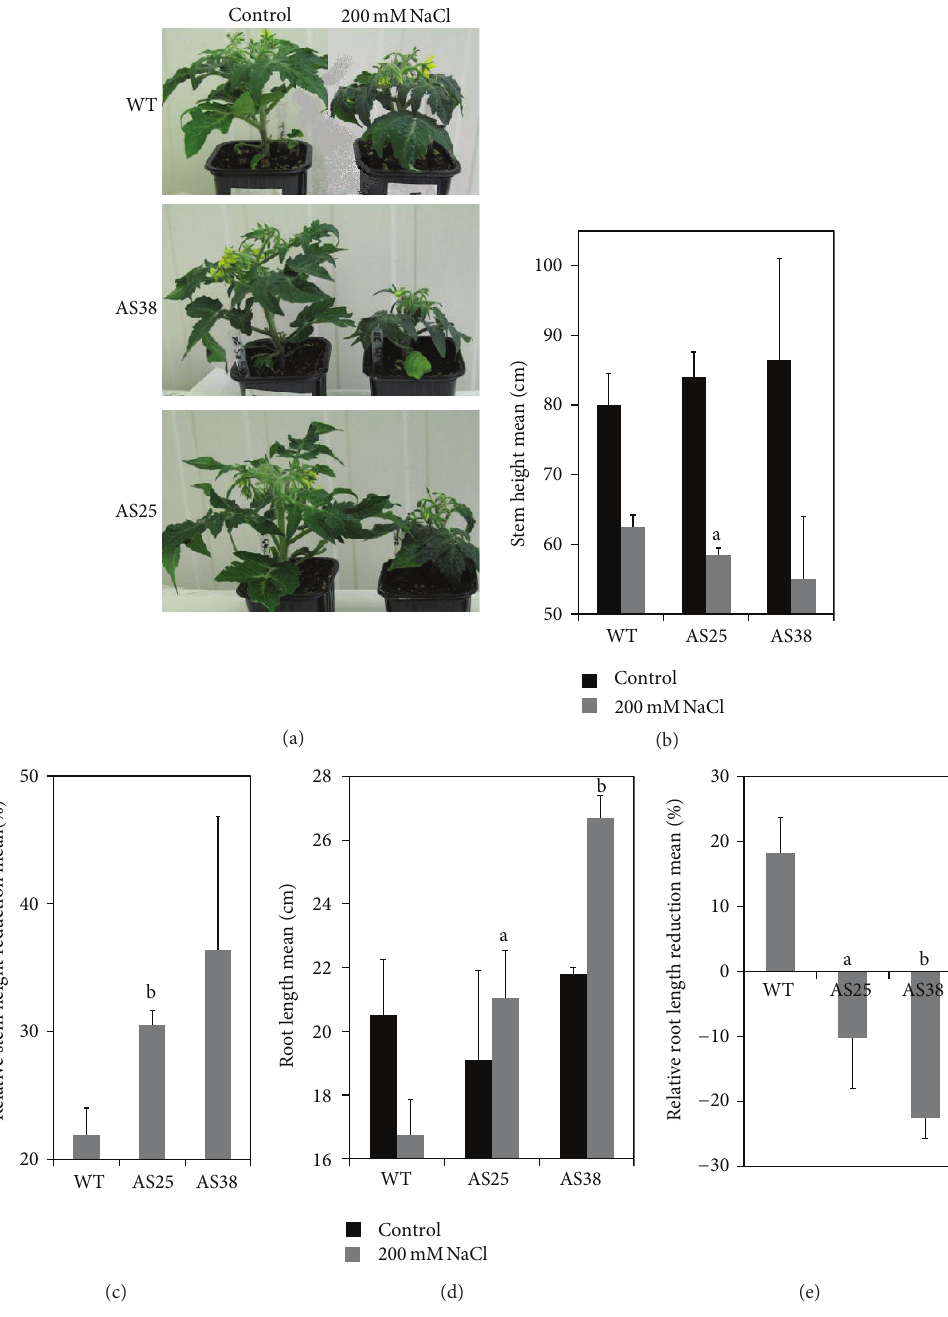
Figure 2: Salt stress effect on wild type and Sl-ERF.B.3 antisense lines growth. (a) Photographs of both Sl-ERF.B.3 antisense transgenic tomato lines (AS38 and AS25) and wild type (WT) were taken at sampling time after six weeks of treatment (irrigation by 200mM NaCl solution). Control: plants were grown under normal growth conditions. Arrows show the leaf epinastic curvature induced by salt stress. Stem height (b) and root length (d) means are assessed in two Sl-ERF.B.3 antisense transgenic tomato lines (AS25 and AS38) and in wild type (WT) grown for six weeks on compost in absence (black bars) or in presence of NaCl (200mM NaCl) (grey bars) in irrigation solution. Percentages of relative reduction in stem height mean (c) and that in root length mean (e) between control (0mM NaCl) and salt stressed (200mM NaCl) plants of both wild type (WT) and Sl-ERF.B.3 antisense transgenic lines (AS25 and AS38) are presented. Data are means of three replications ± standard error. Letters indicate significant differences between wild type and transgenic lines according to Student’s 𝑡 -test (a: 𝑃 < 0.05 , b: 𝑃 < 0.01